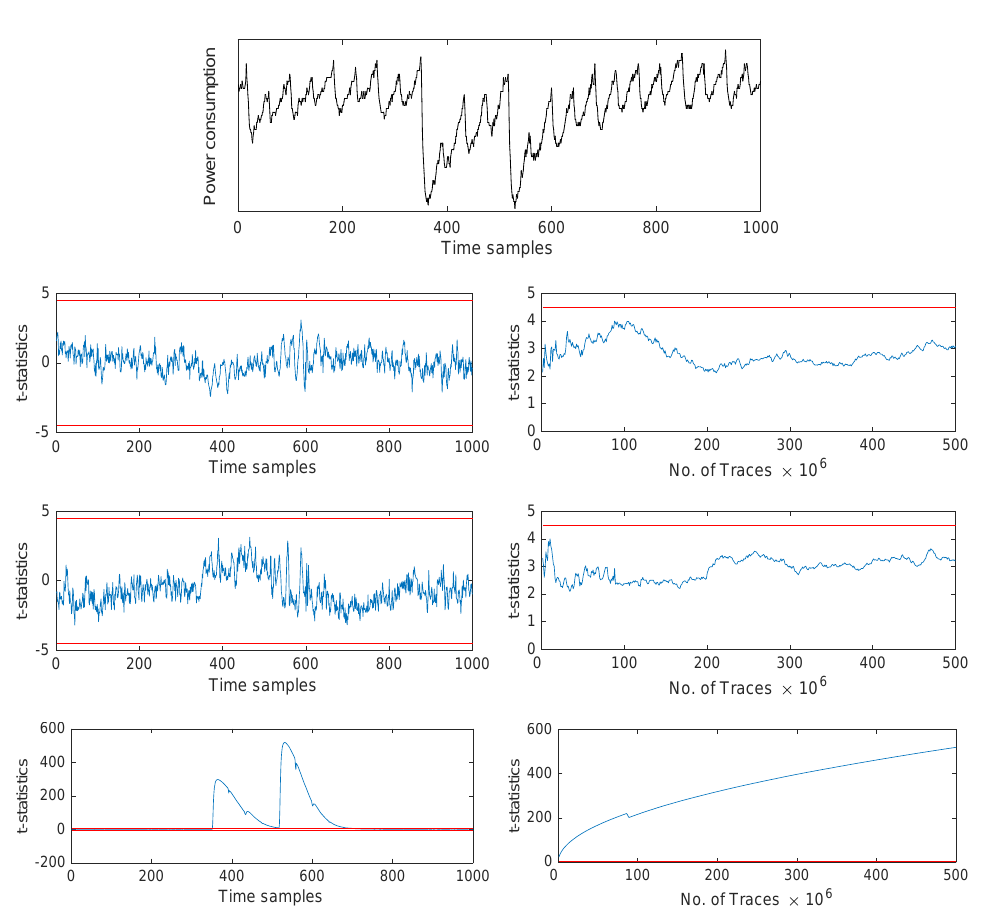
Figure 16: Sample power trace and univariate non-specific t -test results with 500 million measurements for two composed DOM-indep multiplications ( d = 2) based on GF (2 4 ) multipliers with all registers applied. The second to fourth row show the t -statistics for the statistical moments 1 to 3, respectively, arranged like before.